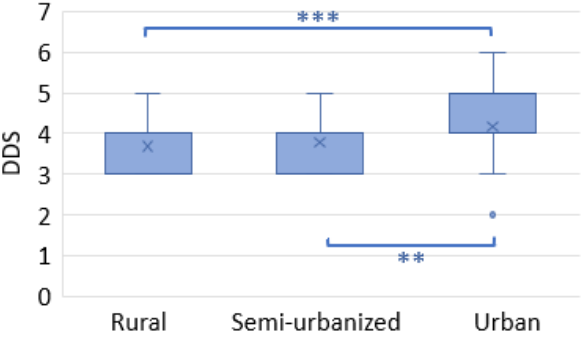
Figure 5. Dietary diversity score (DDS). The box plots show the median and interquartile range (IQR). “x” is the mean and blue dots are outliers. *** p < 0.001 ** p < 0.01 (Mann–Whitney test).